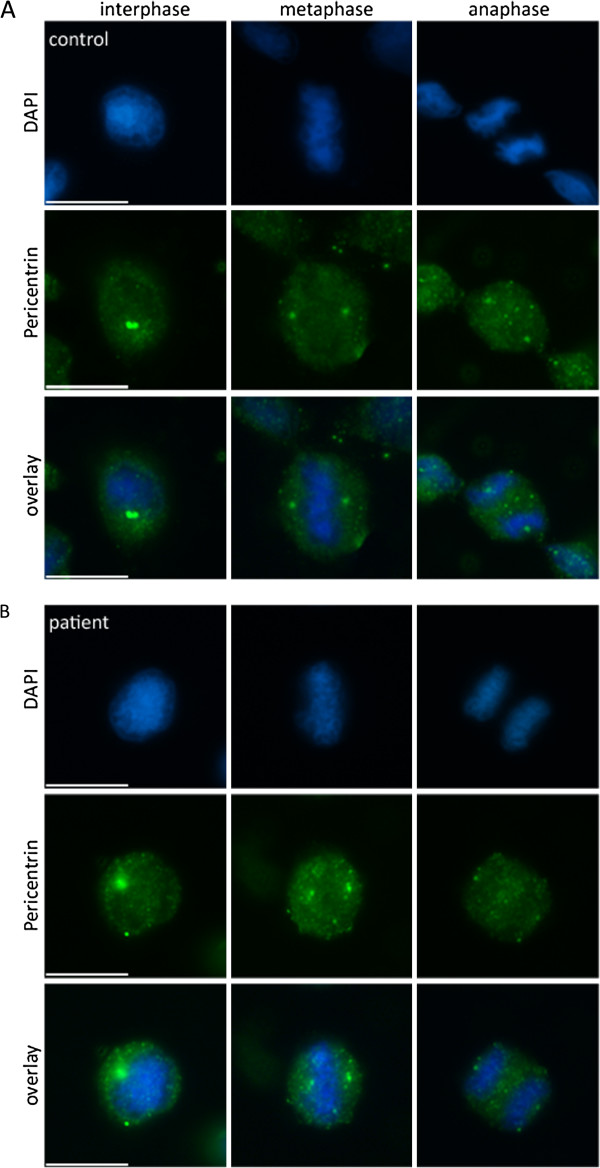
Pericentrin in CDK5RAP2 mutant patient and control cells. No difference was detected regarding the subcellular localization of pericentrin throughout the cell cycle in immortalized lymphocytes of (A) control and (B) MCPH3 patients (here patient 2), however the staining in patients was weaker and the signal more diffuse.